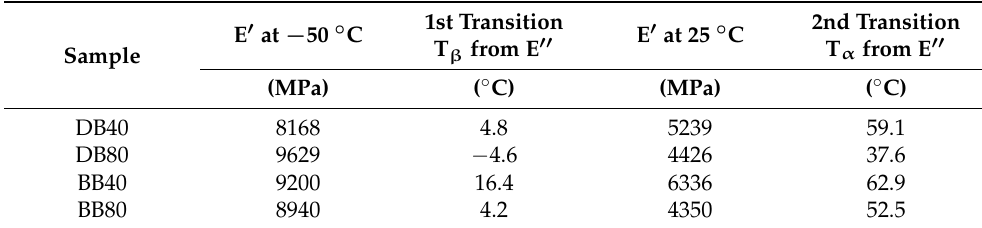
Figure 6. Plots of the storage modulus ( a ), tan δ ( b ), and the loss modulus ( c ) as a function of temperature for various DB and BB resin samples with different added amounts of lignin epoxide. Table 7. Storage modulus at the glassy region and transition temperatures for the DB40, DB80, BB40, and BB80 resins.